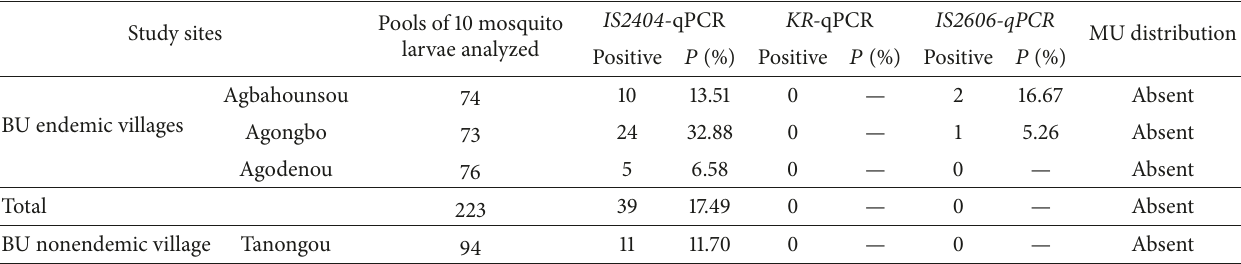
Table 3: Distribution of MU targets in field collected mosquitoes